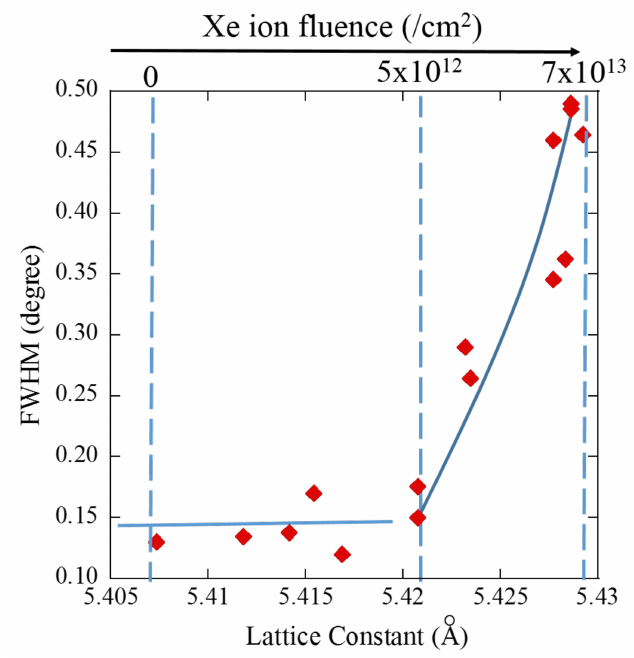
Figure 11. Correlation of lattice constant with FWHM (full width half maximum) of (331) XRD peaks. Xe ion fluence is also shown at the upper x